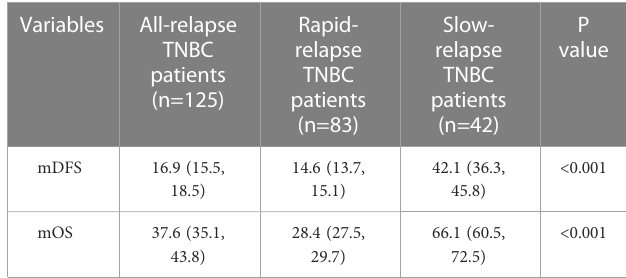
TABLE 5 Prognostic data in different relapsed TNBC patients. Variables